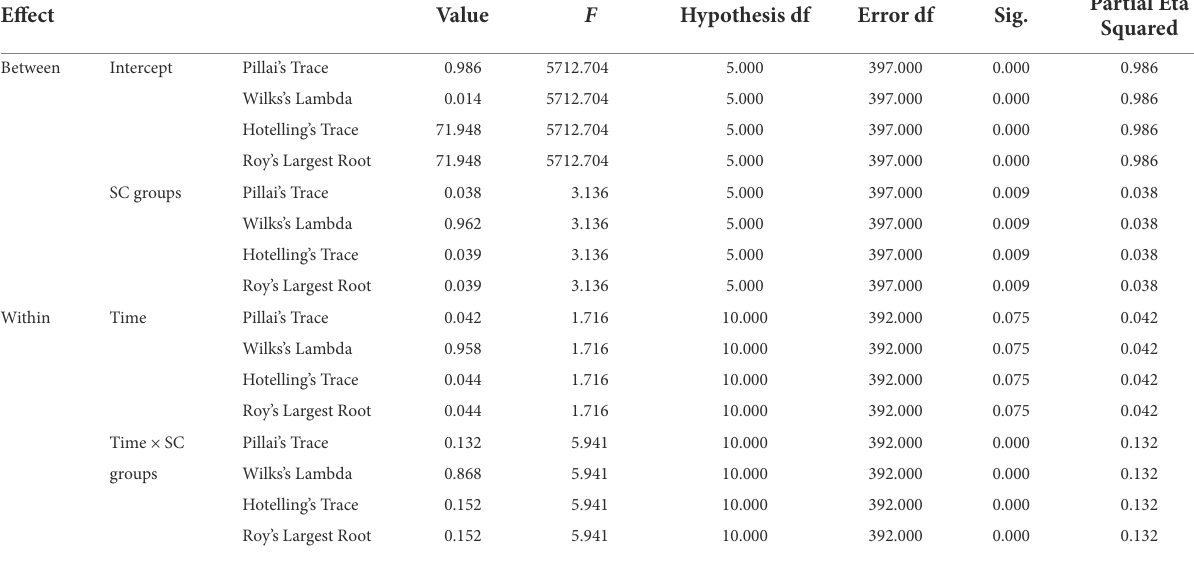
TABLE 3 Results of GLM (General Linear Model): Multivariate tests. Effect